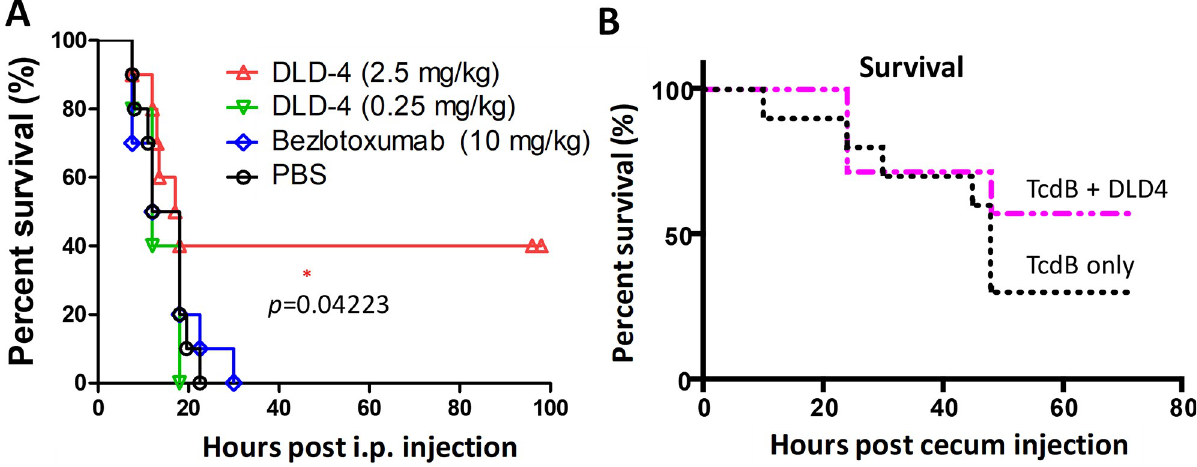
Fig 6. In vivo studies. (A) Mice were IP injected with TcdB (1.5 μ g/kg) alone (PBS, n = 10) or together with DLD-4 (0.25 or 2.5 mg/kg, n = 10) or bezlotoxumab (10 mg/kg, n = 10). Mouse survival rate was monitored, and data were analyzed by Kaplan–Meier survival analysis with log-rank test of significance; p = 0.04 (DLD-4 versus PBS). (B) DLD-4 (5 mg/mouse) was mixed with TcdB (15 μ g/mouse) in 100 μ L PBS and injected immediately into the cecum of mice ( n = 7). The control group received the same dose of TcdB alone ( n = 10). Mouse survival was monitored for 3 days, and the data were analyzed by Kaplan–Meier survival analysis; p = 0.349 (TcdB alone versus TcdB + DLD-4). IP, intraperitoneally; TcdB, C . difficile toxin